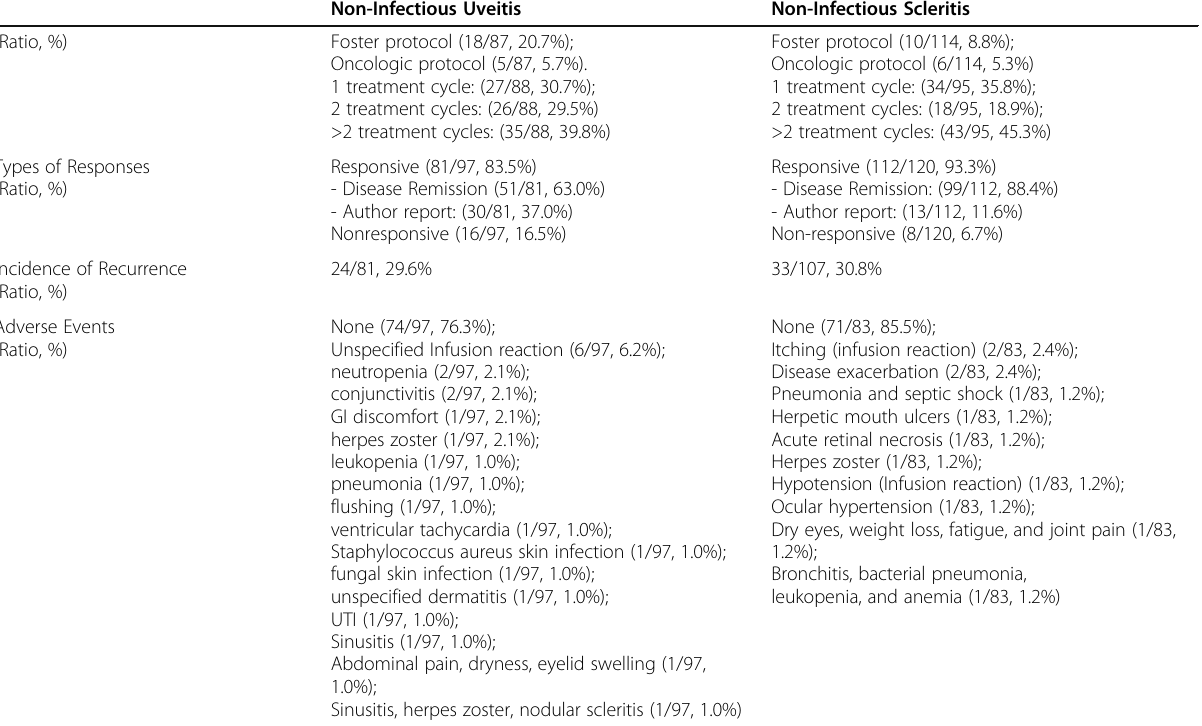
Table 1 Rituximab use in refractory non-infectious uveitis and scleritis - summary of comprehensive literature review (Continued) Non-Infectious Uveitis Non-Infectious